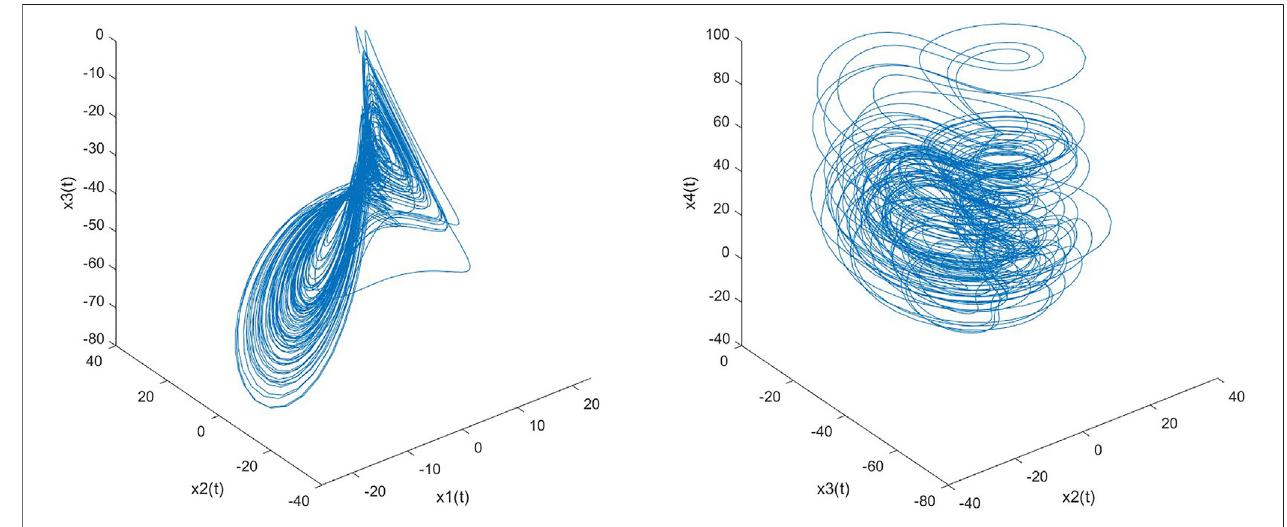
FIGURE 1 | Chaotic attractor of hyperchaotic Liu